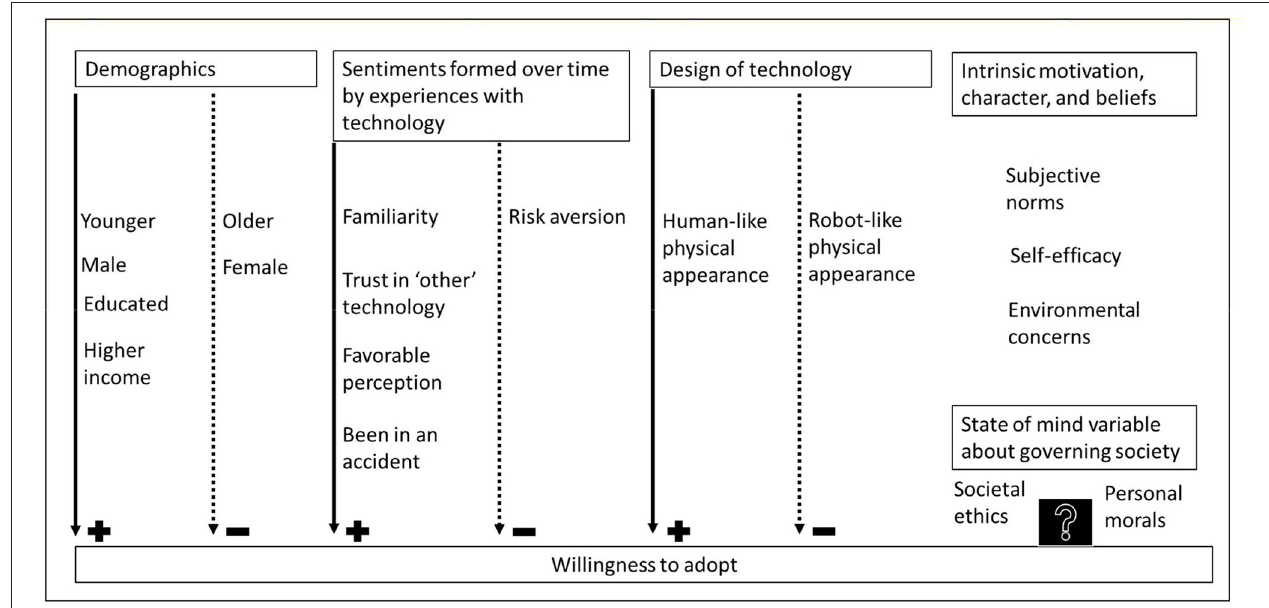
FIGURE 1 | State of mind variables integrated into exemplary framework on influences AV adoption willingness. Source: for an expanded framework on influences see Gkartzonikas and Gkritza (2019) .